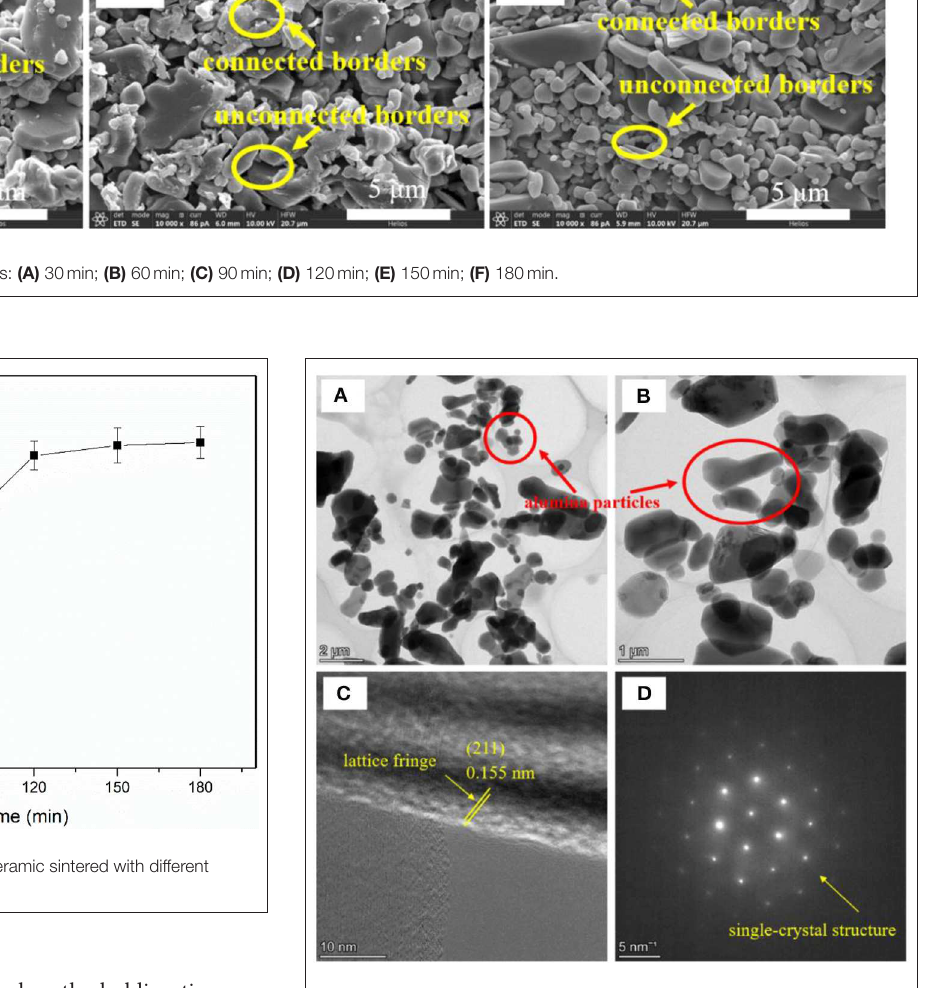
FIGURE 6 | TEM images of 90min sintered samples: (A) TEM image; (B) Further enlarged TEM image; (C) HRTEM image; (D) Selected area electron diffraction